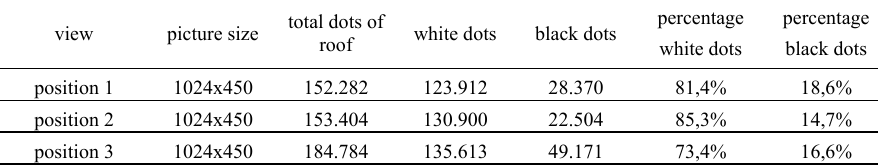
Table 3: Transparency at three views at the example of the structure cube